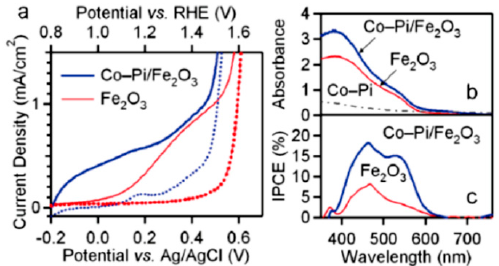
Figure 17. ( a ) Dark (dashed) and photocurrent (solid) densities for Fe 2 O 3 (red) and Co–Pi/Fe 2 O 3 (blue) photoanodes, collected using simulated AM 1.5 illumination (1 sun, backside) at a scan rate of 50 mV·s − 1 ; ( b ) Electronic absorption and ( c ) IPCE spectra for Fe 2 O 3 and Co–Pi/Fe 2 O 3 at 1.23 and 1 V vs. RHE, respectively. The absorption spectrum of Co–Pi on FTO without Fe 2 O 3 is included in ( b ), but no photocurrent was detected for these anodes. Reprinted with permission from ref. [66]. Copyright 2018. American Chemical Society.